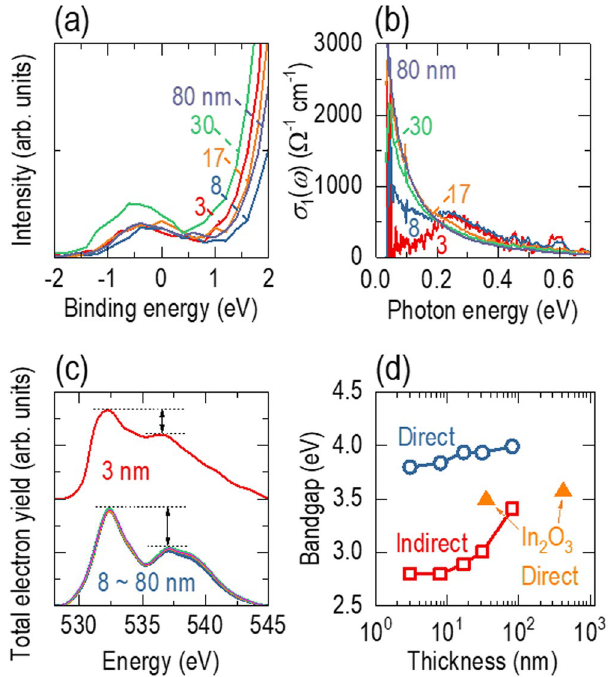
Figure 3. Electronic bandstructures of ITO epitaxial films with various film thicknesses. ( a ) XPS intensity near the Fermi level. We observed a strong signal near the Fermi level for all films. ( b ) Optical conductivity as a function of photon energy. There is a nonnegligible spectral weight near a very small photon energy (~0.03 eV), even in the 3-nm-thick film. ( c ) X-ray absorption spectroscopy (XAS) of the total electron yield to investigate the conduction band. The XAS spectra do not significantly change as the film thickness approaches 8 nm, indicating preservation of the conduction band. We highlight the change in the absorption ratio by the length of the arrows. ( d ) Bandgap as a function of film thickness. The indirect and direct bandgaps decrease with decreasing film thickness. The direct bandgap of In 2 O 3 epitaxial films taken from ref. 19 shows a similar